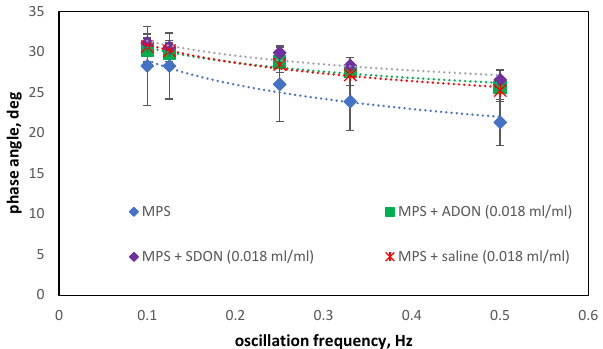
Figure 7. Changes of the phase angle in the oscillation of air/liquid interface with MPS (concentration of 2.5 mg/mL) in presence of saline, ADON or SDON.